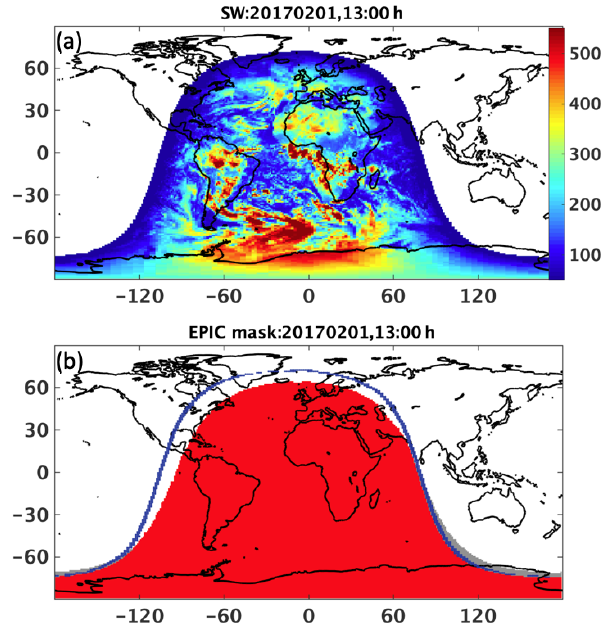
Figure 6. An example of the daytime SW flux distributions from the CERES SYN1deg product at 13:00UTC on 1 February 2017 (a) and the corresponding daytime areas (in red) and nighttime areas (in grey) that are visible to NISTAR and the terminator boundary (in blue) (b)